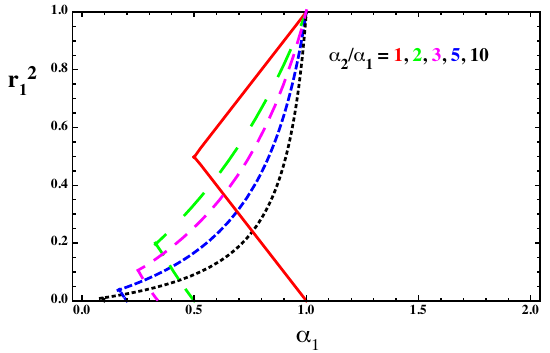
Figure 3 . The allowed values of (cid:11) 1 ; r 2 for (cid:12)xed ratios of (cid:11) 2 =(cid:11) 1 = 1 ; 2 ; 3 ; 5 ; 10. The two sets of 1 curves are derived from the two constraint equations in (3.9). The stability inequality is satis(cid:12)ed for points with (cid:11) 1 to the right of both curves of the same colour (red, green, purple, blue and black for increasing (cid:11) 2 =(cid:11) 1 ). The point at which the two curves meet corresponds to the kink that appears in (cid:12)gure 2 when (cid:11) 1 + (cid:11) 2 = 1.